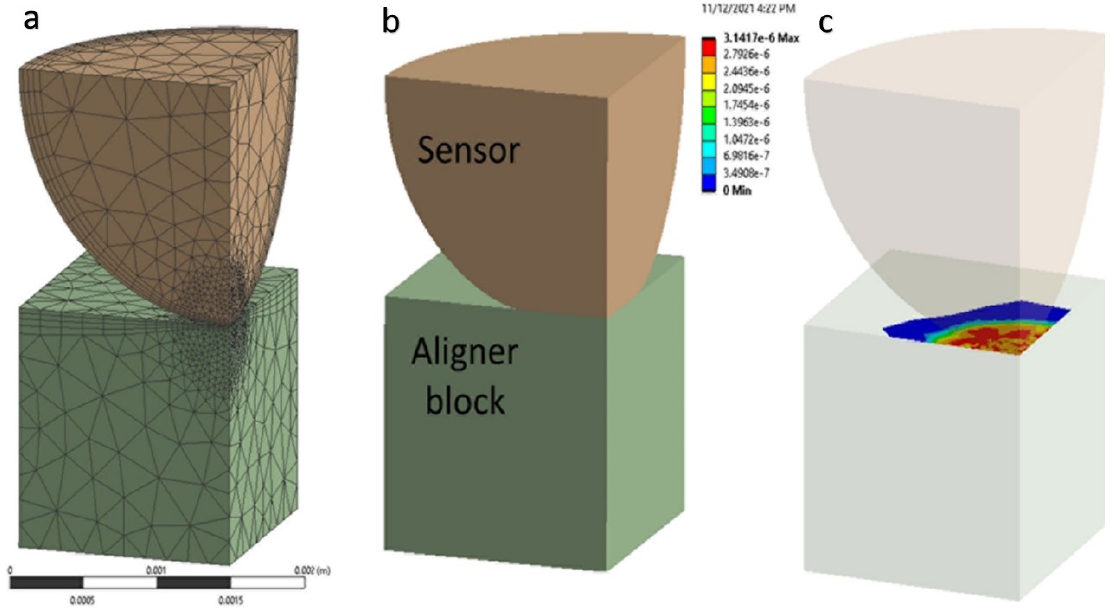
Figure 4. FEM contact simulation for the orthodontic sensor: ( a ) FEM mesh ( b ) deformed geometry ( c ) surface pressure.